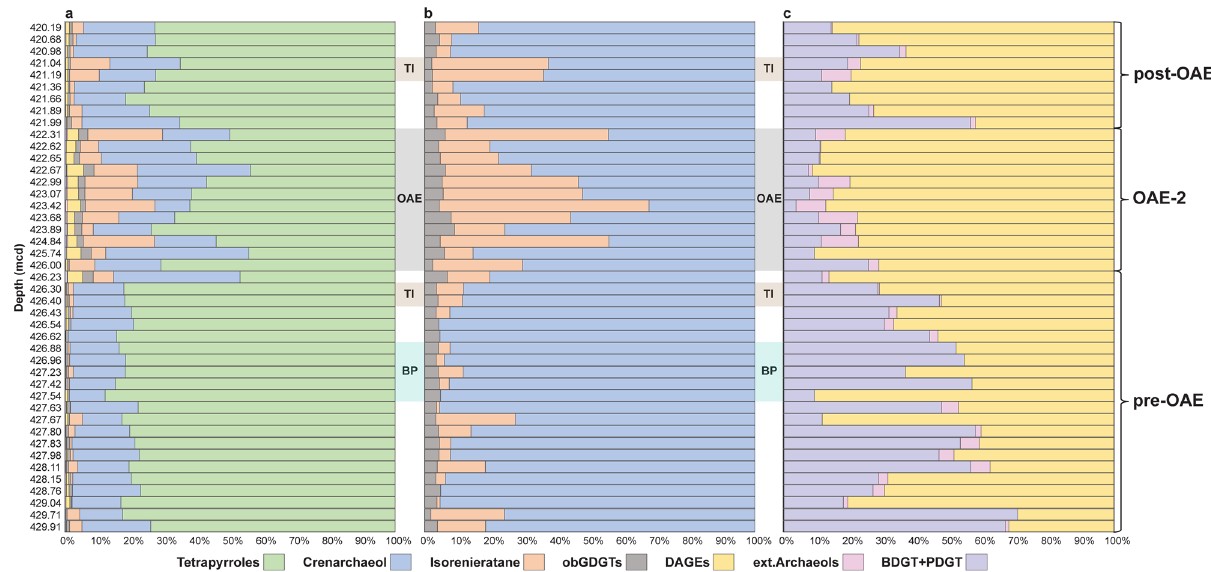
Fig. 3 Biomarker fractional abundances preceding, during, and following OAE-2. a The fractional abundance of individual biomarkers, representative of the entire water column. b The fractional abundance of biomarkers derived exclusively from intermediate depths. c The fractional abundance of lipids produced by deep water microbial communities. The color-shaded intervals represent the timing and duration of the pre-OAE biotic perturbation (BP), thallium isotope excursions (Tl), and OAE-2 (OAE).